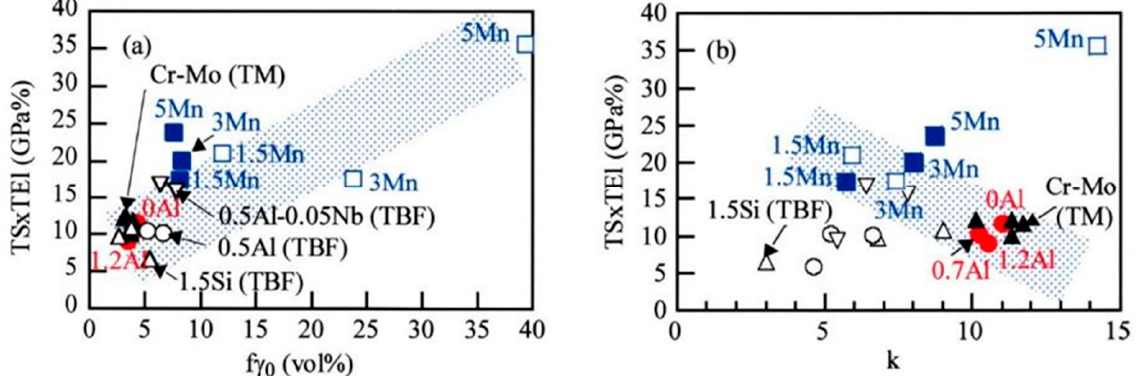
Figure 11. ( a ) Relationship between tensile strength (TS) and initial retained austenite fraction ( f γ 0 ). ( b ) Relationships between product of TS and total elongation (TS×TEl) and strain-induced transformation factor ( k ) in 0.20C-1.50Si-1.24Mn-0.20Cr-0.022Al-0.0028 (0Al), 0.20C-0.73Si-1.24Mn-0.19Cr-0.72Al-9.0027B (0.7Al), and 0.20C-0.20Si-1.24Mn-0.20Cr-1.22Al-0.0026B (1.2Al) TM steels ( ● ) [55,88], 0.2C-1.5Si-1.5Mn-(0-1.0)Cr-(0-0.2)Mo (Cr-Mo) TM steels ( ▲ ) [53], 0.2C-1.5Si-(1.5-5.0)Mn (1.5Mn, 3Mn and 5Mn) M-MMn ( █ ) [59] and D-MMn ( □ ) [39,40] steels, 0.2C-1.5Mn-0.99Si-0.49Al (0.5Al) TBF steel ( ○ ), 0.2C-1.5Mn-1.00Si-0.48Al-0.049Nb (0.5Al-0.05Nb) TBF steel ( ▽ ) [14], and 0.2C-1.5Si-1.5Mn-0.05Nb (1.5Si) TBF steel ( △ ) [51]. ( a ) and ( b ) are produced from the results in references [14,39,40,51,53,55,59,88].